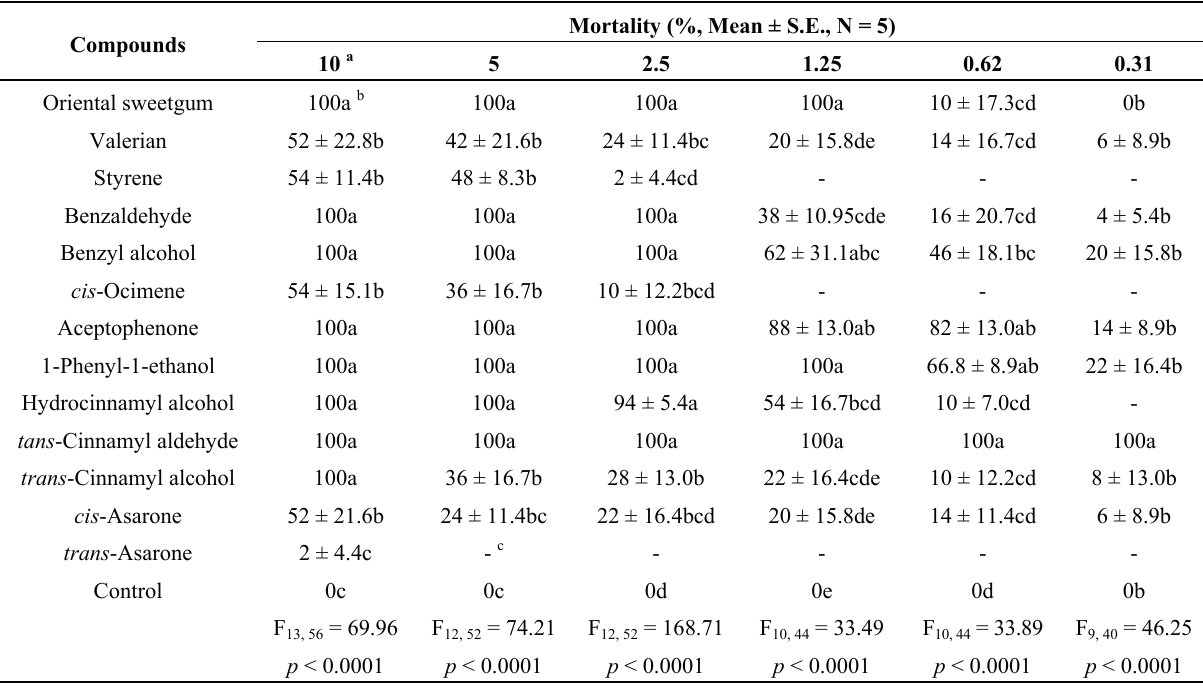
Table 2. Fumigant antitermitic activity of oriental sweetgum and valerian essential oils and their components against Japanese termites at 2